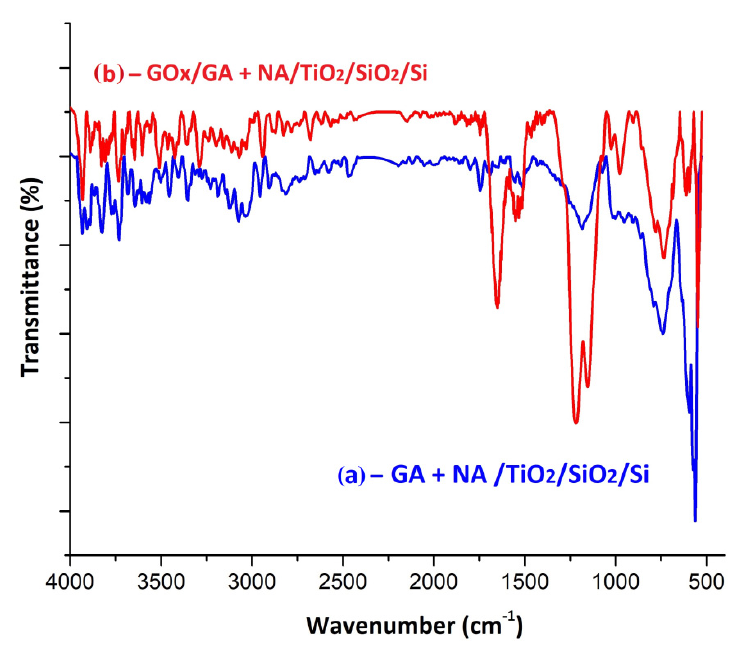
Figure 10. FTIR spectra for ( a ) a representative sample of GA deposited on a nanostructured TiO 2 film and ( b ) for GOx anchored to a GA–TiO 2 probe. film and ( b ) for GOx anchored to a GA–TiO 2 probe.